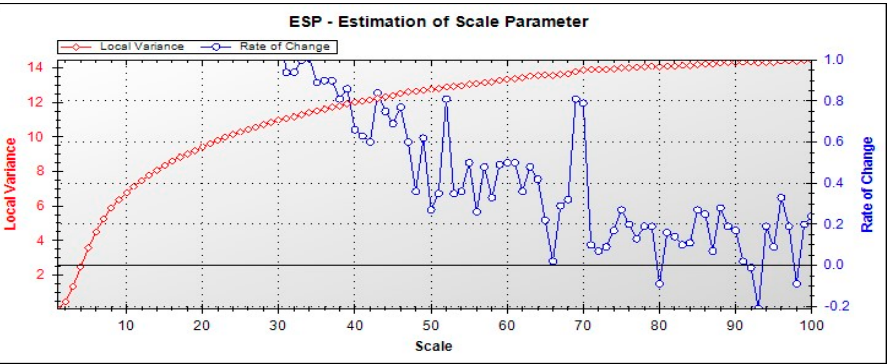
Figure 4. ESP result.